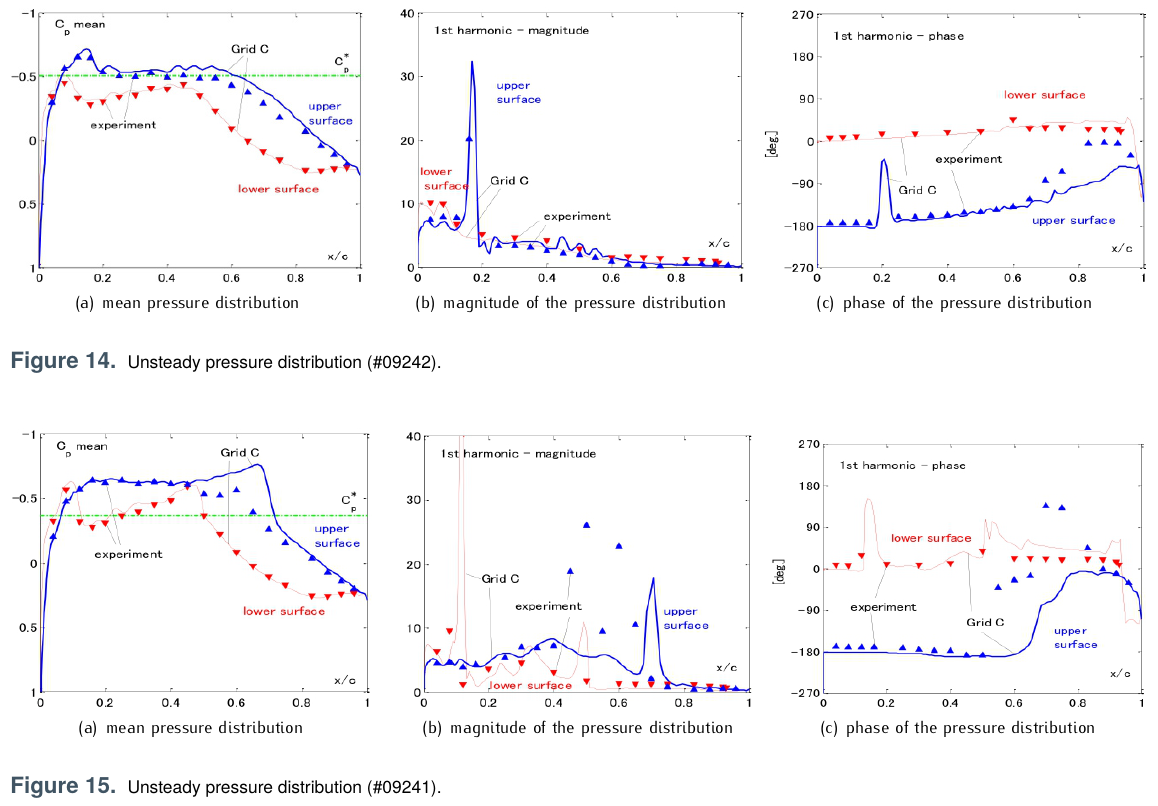
Figure 15. Unsteady pressure distribution